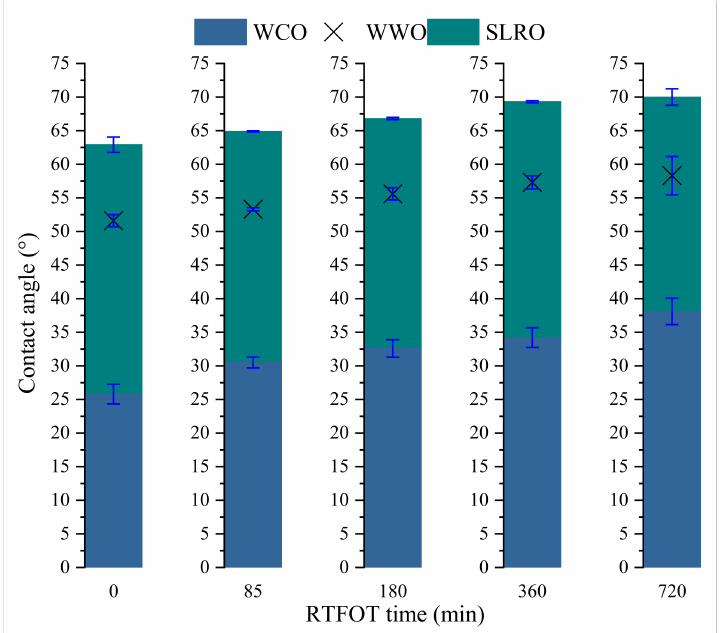
Figure 2. Contact angle between bio-oils and different aged bitumen surfaces at 408.15 K.